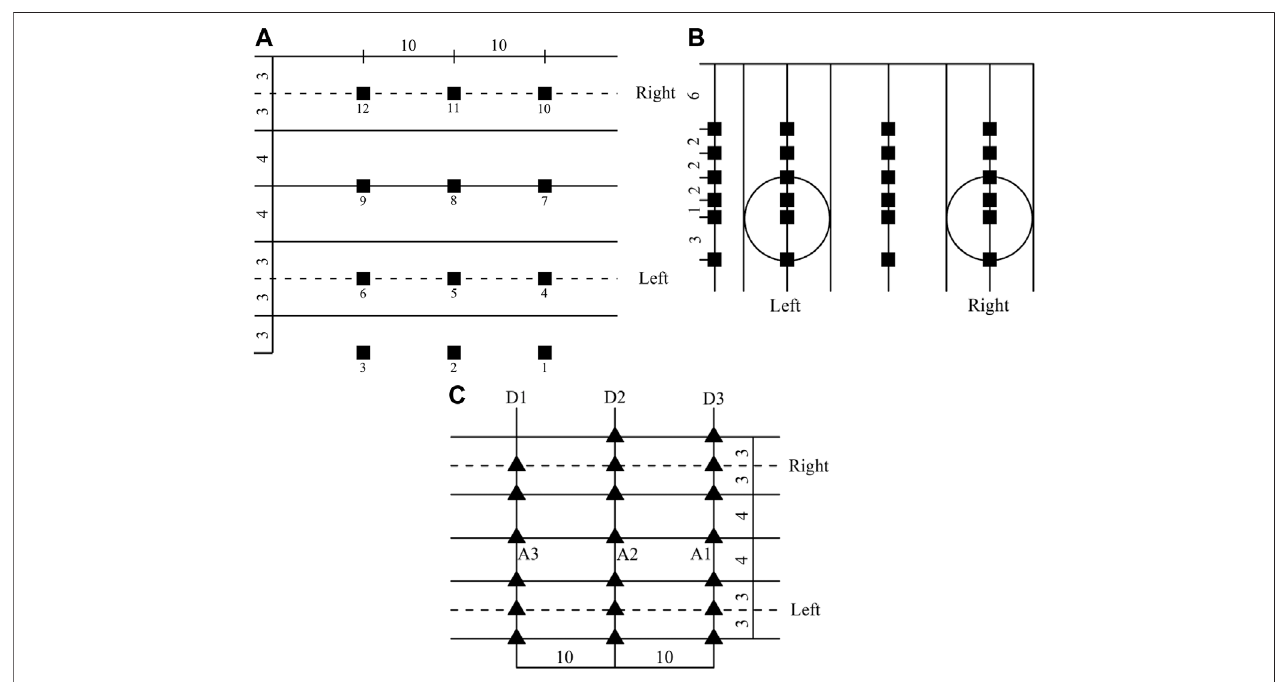
FIGURE 1 | Layout of measuring points (unit: m): (A) pore pressure and earth pressure in plane, (B) pore pressure and earth pressure in depth, and (C) soil layer settlement.